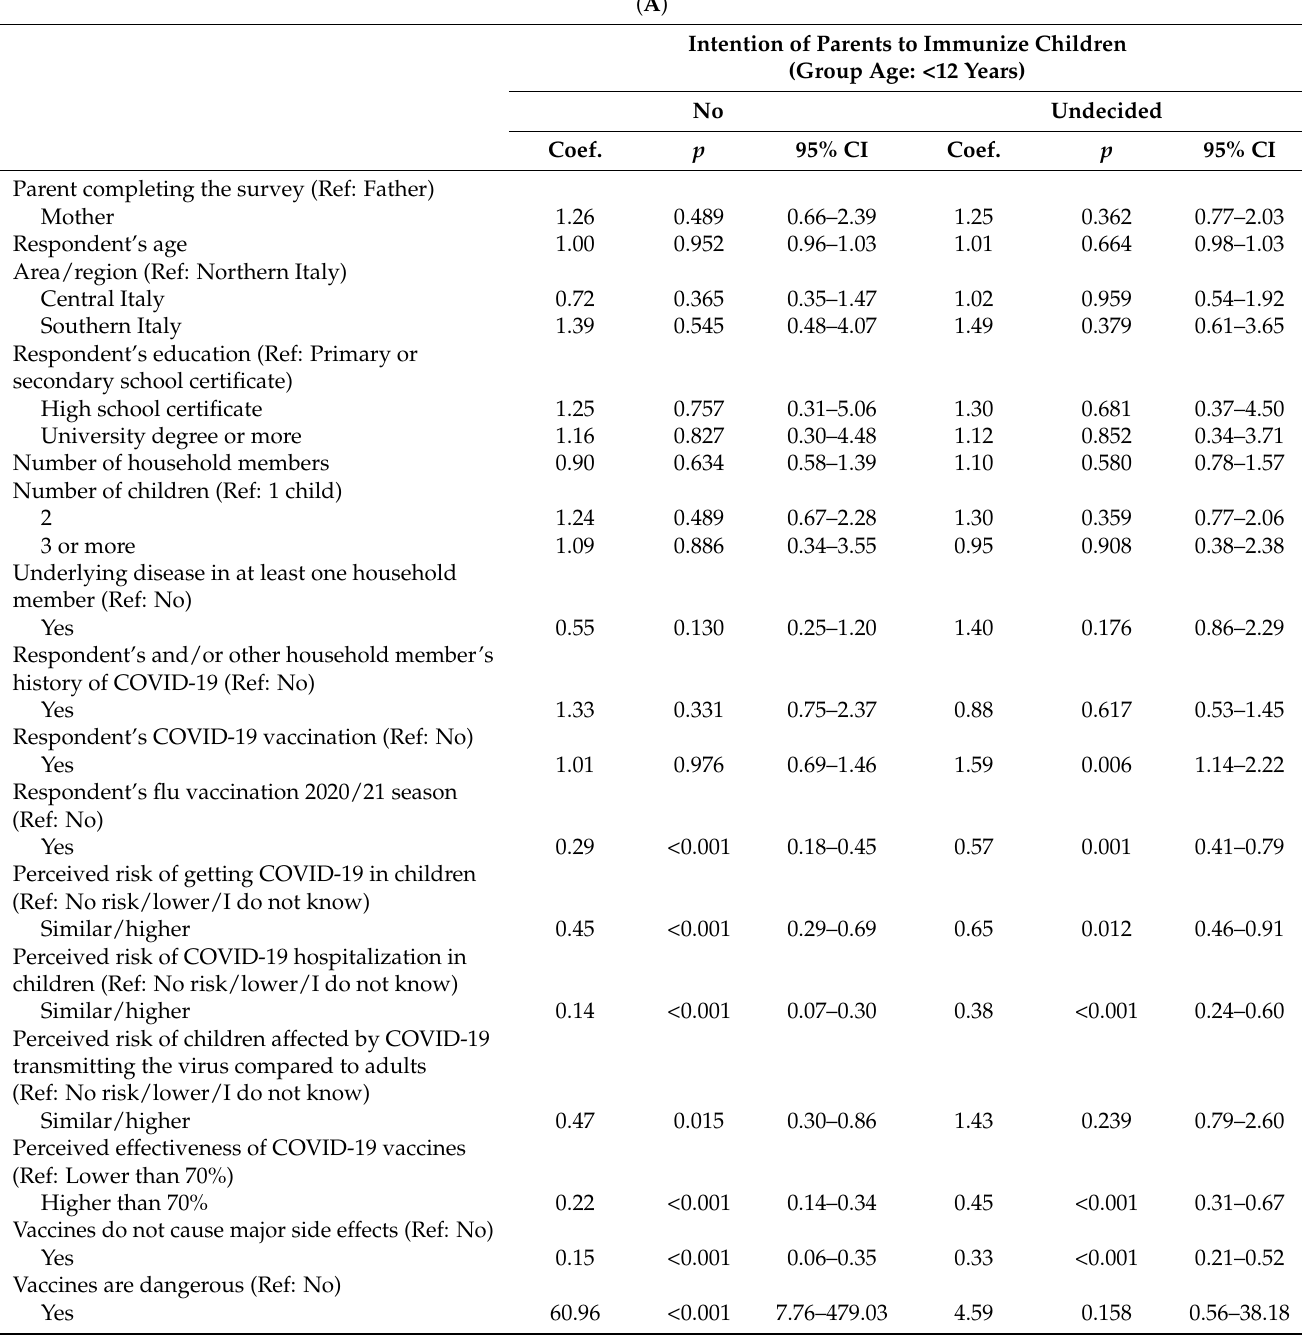
Table 4. (A) Factors associated with a negative and undecided intention to vaccinate in children < 12 years. (B) Factors associated with a negative and undecided intention to vaccinate in children ≥ 12